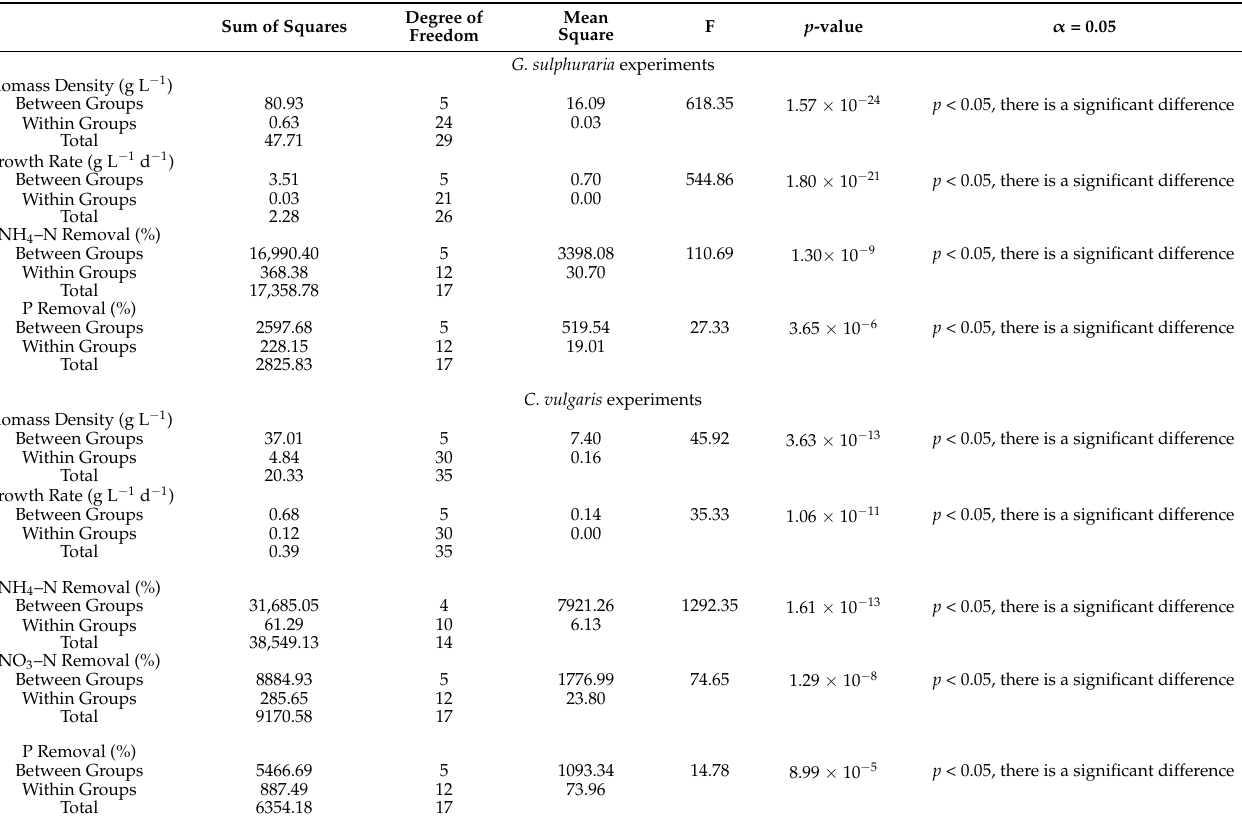
Table 4. ANOVA statistical evaluation test to analyze the variations in final biomass density, growth rate, N and P removal efficiency in different experiments using G. sulphuraria and C. vulgaris